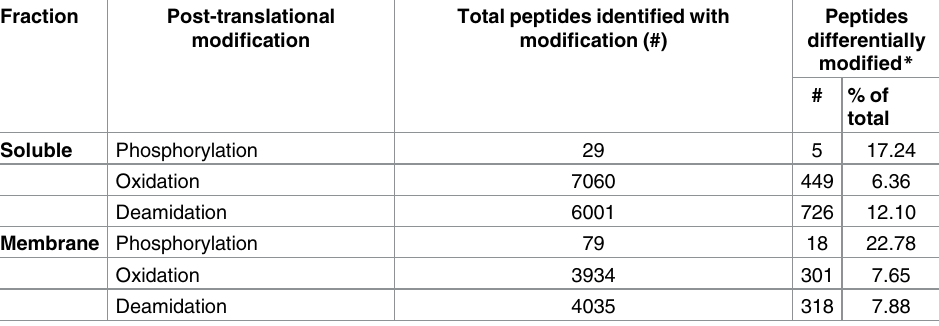
Table 1. Number of peptides with altered post-translational modifications due to RNAlater.